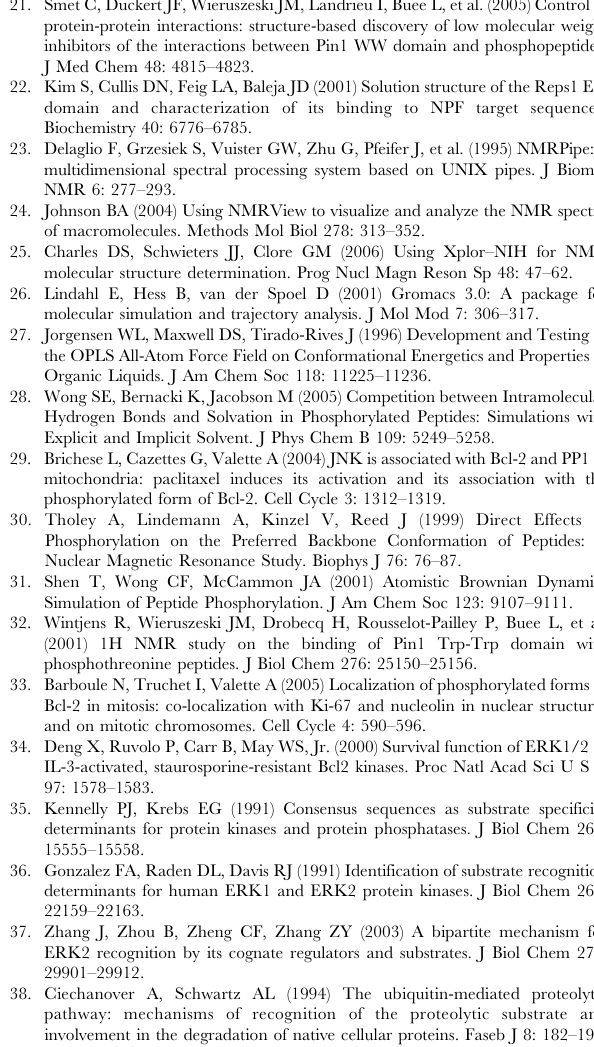
Figure S4 Model for the interaction between Pin1 and pS87 (A) S87 peptide. (B) The pS87 peptide, which contains the pSer-Pro motif, undergoes conformational changes after phos- phorylation. (C) Structural model of the Pin 1 WW domain complexed with pS87 was generated using GOLD v3.1.1 (Cam- bridge Crystallographic Data Centre, UK). (D) The structure of the Pin1 WW domain complexed with Tau peptide (PDB 1I8G). The pSer-Pro motif is shown in red. The model shows that phosphorylation of the Bcl-2 S87 peptide undergoes a conforma- tional change and the resulting structure resembles the complex structure of the WW domain and the Tau peptide. Figure S5 CSI analysis of S87 and pS87. Chemical shift index analysis for the peptides. The H a chemical shifts were compared with that of the random coil of each residue. Figure S6 The amide region of the peptides. 1D proton NMR was collected as described in the ‘‘Materials and methods’’.